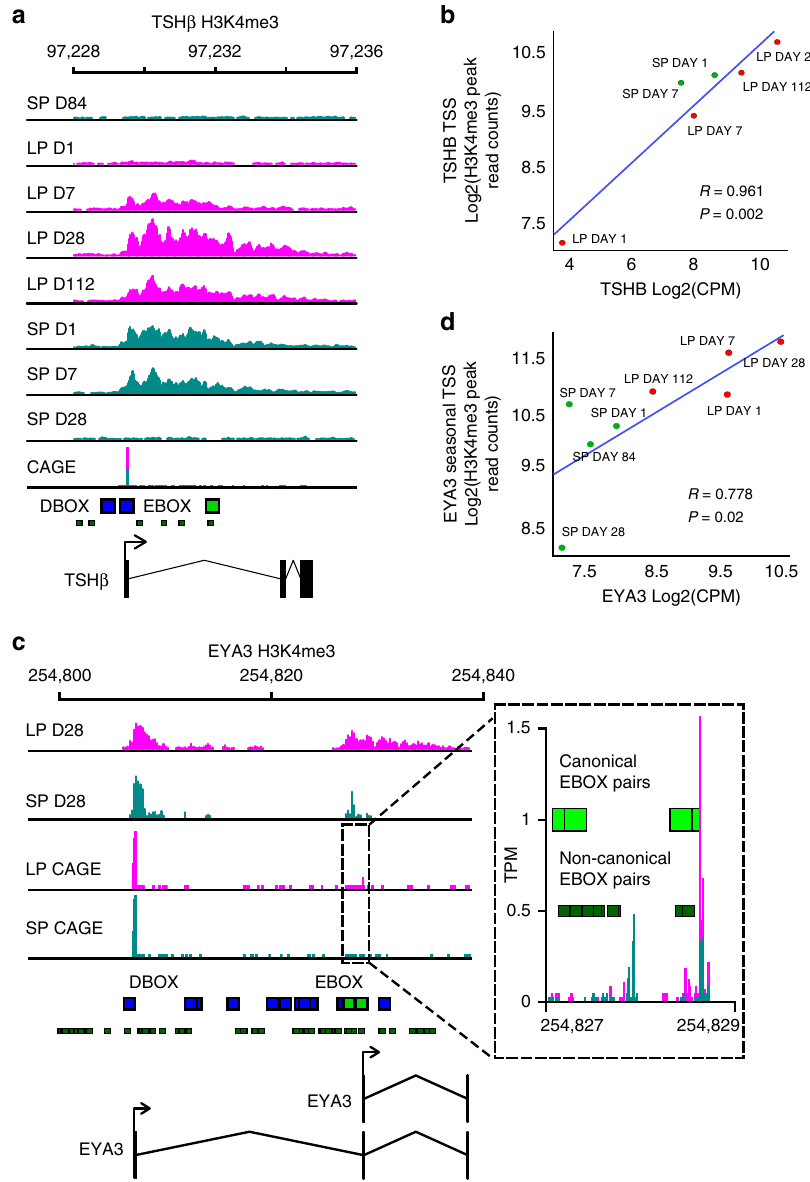
Fig. 2 TSH β and EYA3 are epigenetically regulated over the season. a ChIP-seq tracks for TSH β gene H3K4me3 peaks across all experimental time- points. Chromosome 1 region is shown. CAGE-seq track identifying active TSSs in LP day 28 vs SP day 28. Pink represents samples in long photoperiod and marine green represents short photoperiod. Solid green boxes are canonical E-box motifs. Blue boxes are D-box motifs. b Correlation plot for TSH β log 2 H3k4me3 peaks from ChIP-seq versus TSHb log 2 counts per million (CPM) from RNA-seq. Red symbols are LP sampling points, green are SP sampling points. Correlation coef fi cient R is shown. R = 0.961, p -value = 0.002. Note: SP day 28 and 84 are not included because the H3K4me3 peaks are very low. c ChIP-seq tracks for EYA3 gene H3K4me3 peaks. Chromsome 2 region is shown. CAGE-seq track identifying active TSSs in LP day 28 vs SP day 28. Zoom in box provided to identify the downstream promoter. d Correlation plot for EYA3 downstream TSS log 2 H3K4me3 peaks from ChIP-seq versus EYA3 log 2 CPM from RNA-seq. Red symbols are LP sampling points, green are SP sampling points. Correlation coef fi cient R is shown. R = 0.778, p -value =